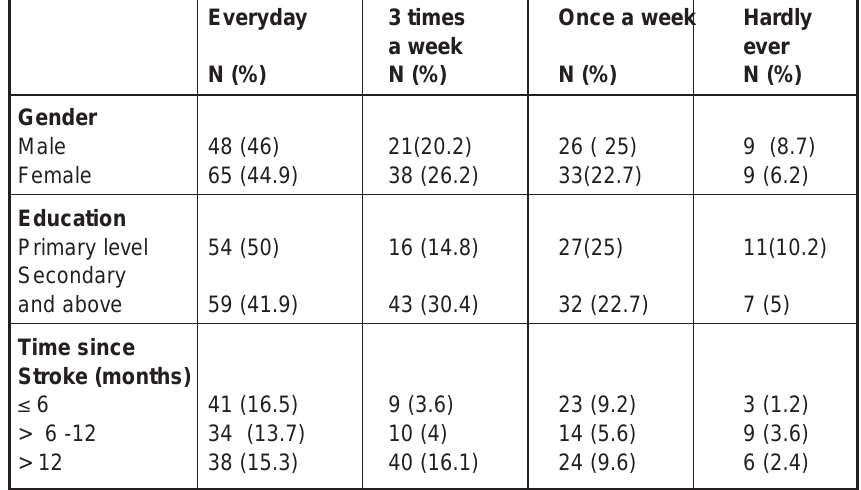
Table 2: Frequency of participation in physical activity in relation to gender, education, employment status and time since stroke